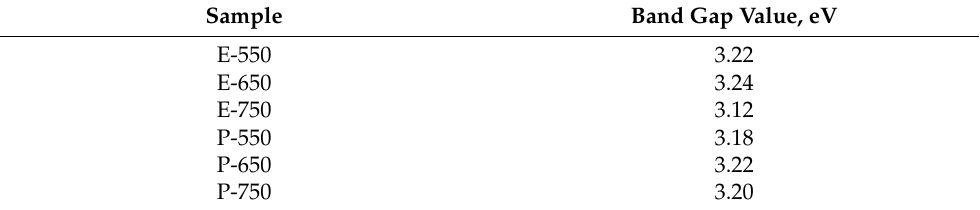
Table 5. Band gap values of the samples calculated from UV–DR